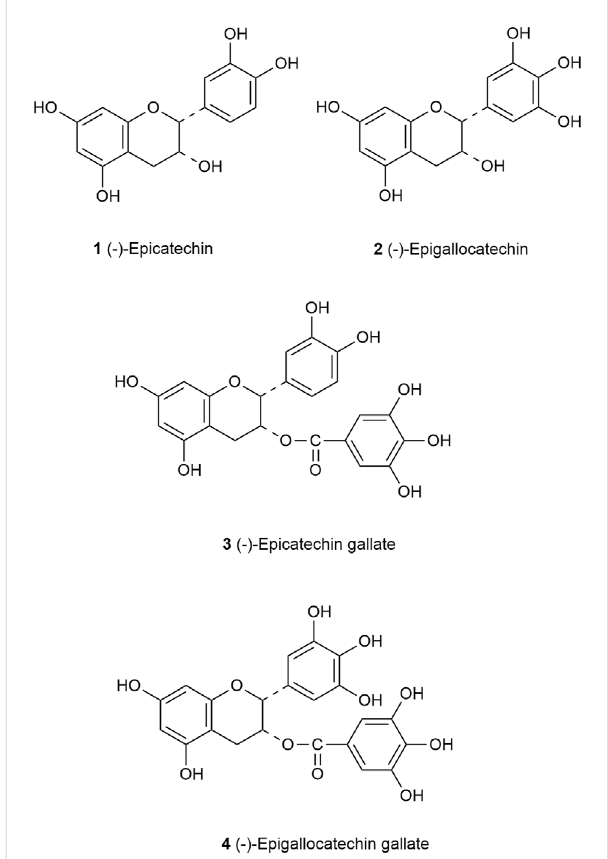
Structure of the principal catechins. EC (1) has an ortho- dihydroxyl group in the B-ring at carbons 3 ′ and 4 ′ and a hydroxyl group at carbon 3 on the C ring. EGC (2) has a trihydroxyl group at carbons 3 ′ , 4 ′ , and 5 ′ on the B ring. ECG (3) has a gallate moiety esteri fi ed at carbon 3 of the C ring, while EGCG (4) has both a trihydroxyl group at carbons 3 ′ , 4 ′ , and 5 ′ on the B ring and a gallate moiety esteri fi ed at carbon 3 on the C